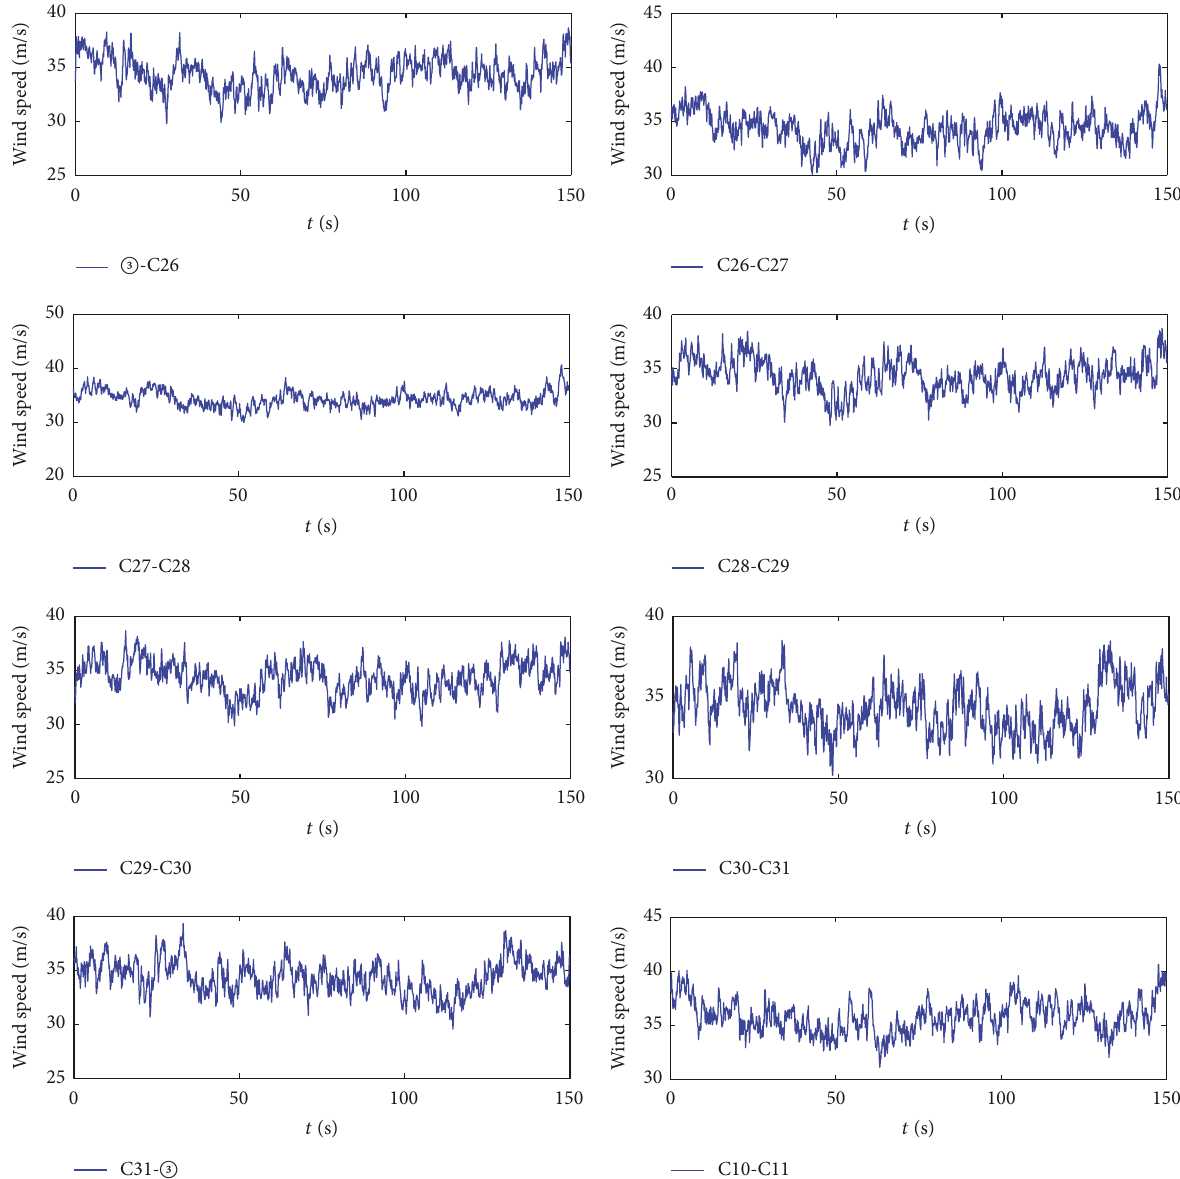
The 𝑥 -direction acceleration time history curves indicate